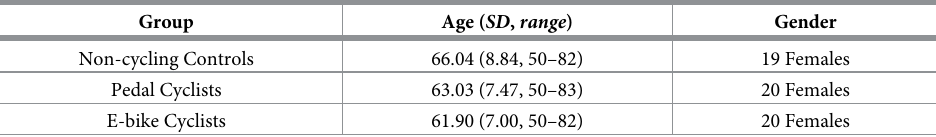
Table 1. Demographic information (mean age, gender, mean years in education [YiE], mean pre-intervention mini-mental state examination [MMSE] score, mean pre-intervention physical activity scale for the elderly [PASE]) for the non-cycling controls, pedal cyclists and e-bike cyclists.